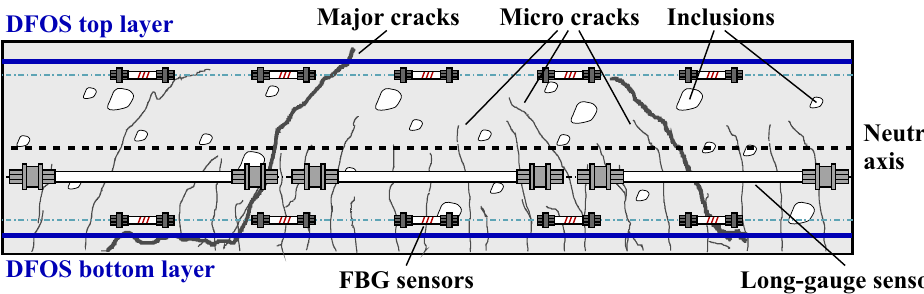
Figure 4. Shape sensing along concrete structures (based on the work in